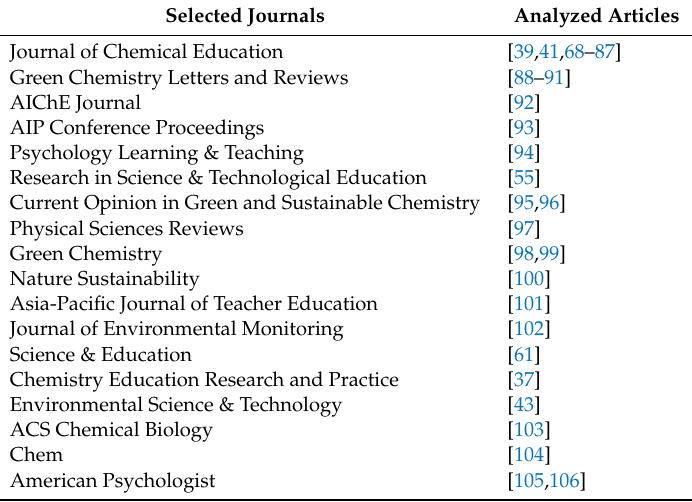
Table 1. The selected journals and the analyzed